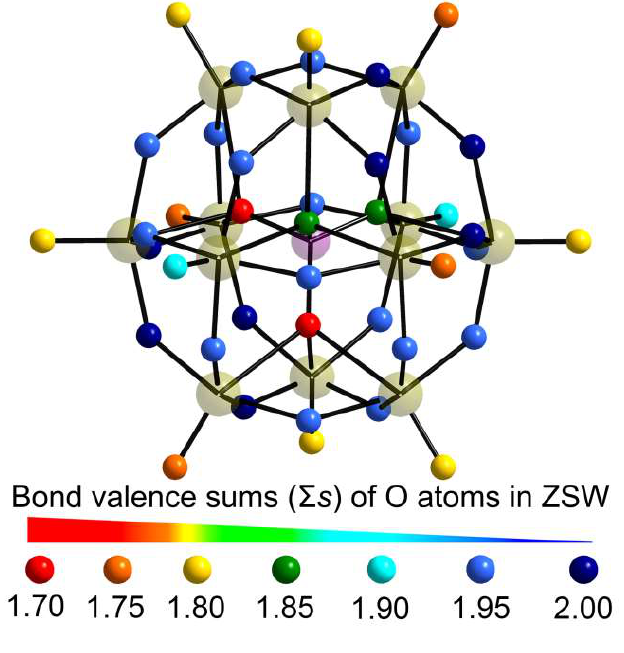
Figure 3. The bond valence sums (Σ s ) of O atoms in the Keggin unit of [Zn 2 (4,4′- bpy)(Phen) 2 ][SiW 12 O 40 ] (ZSW). The extent of protonation for each oxygen atom is indicated by different colors.